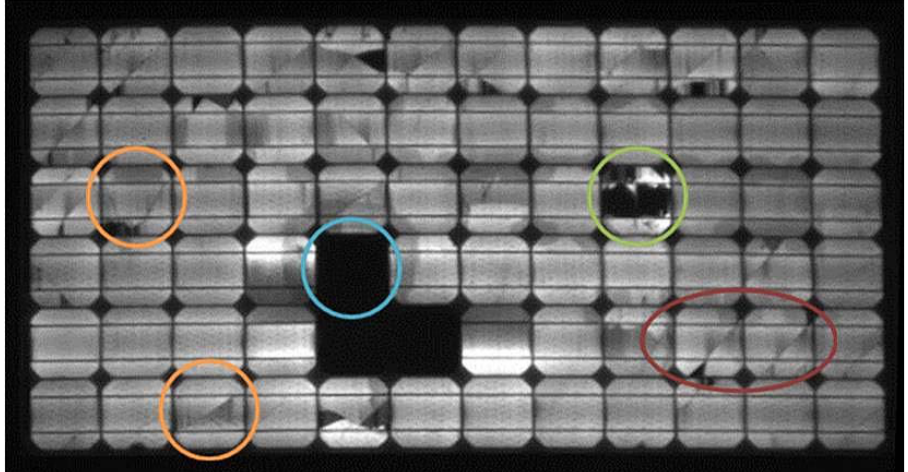
Figure 11. EL image of the 5 A PV panel (100% I sc ) in the pilot plant. Capture made with the camera fixed on a tripod.